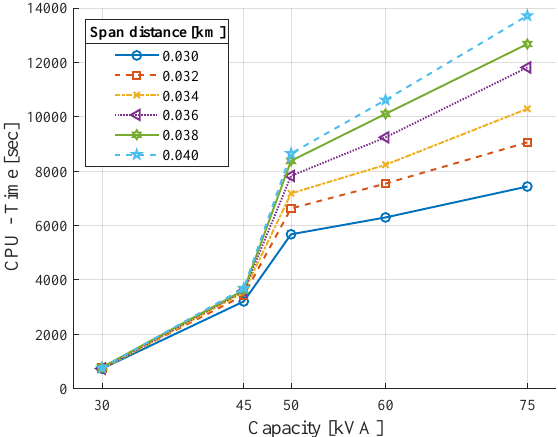
Figure 5. CPU time of modified Prim algorithm with capacity and span constraints.